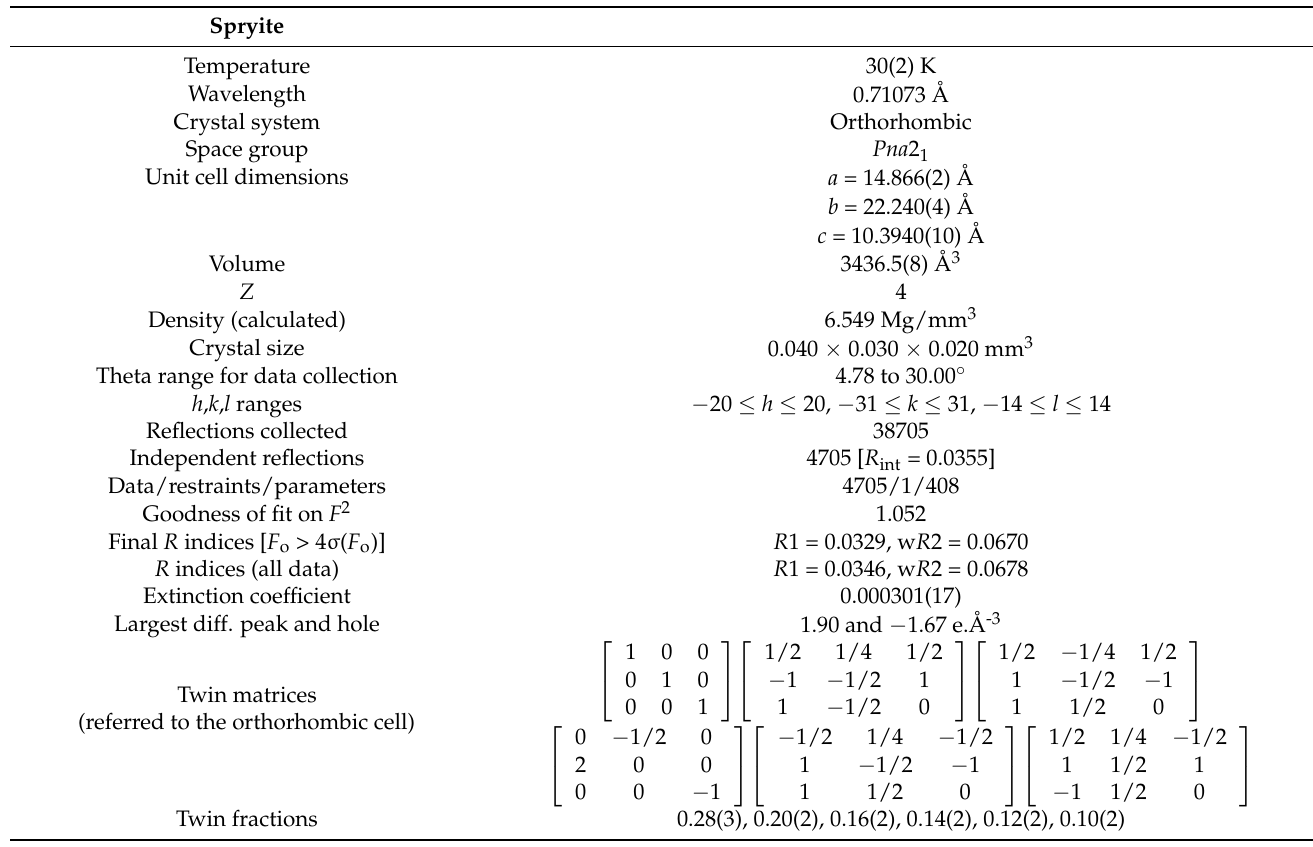
Table 1. Experimental and refinement details for spryite at 30 K.